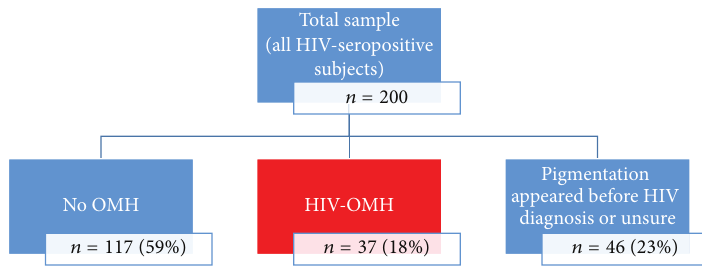
Figure 2: Grouping of the study